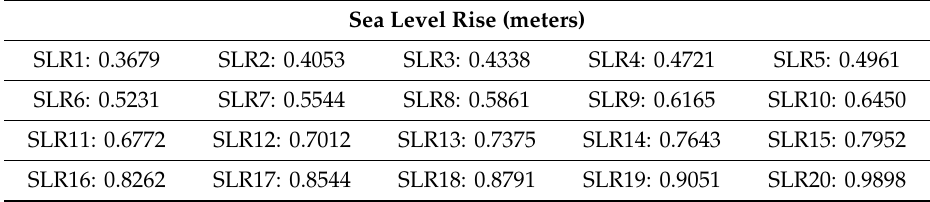
Figure 11. ( a ) Random samples of relative sea level rise for the 243 storms between the years 2080 to 2100, the blue dots represent each of the 243 storms and the grey region indicates the beta distribution between the lower and upper bounds; ( b ) final distribution of SLR scenarios after the 243 storms are combined into 20 bins to reduce computational requirements. Table 3. Relative sea level rise values for the twenty scenarios used in this study.